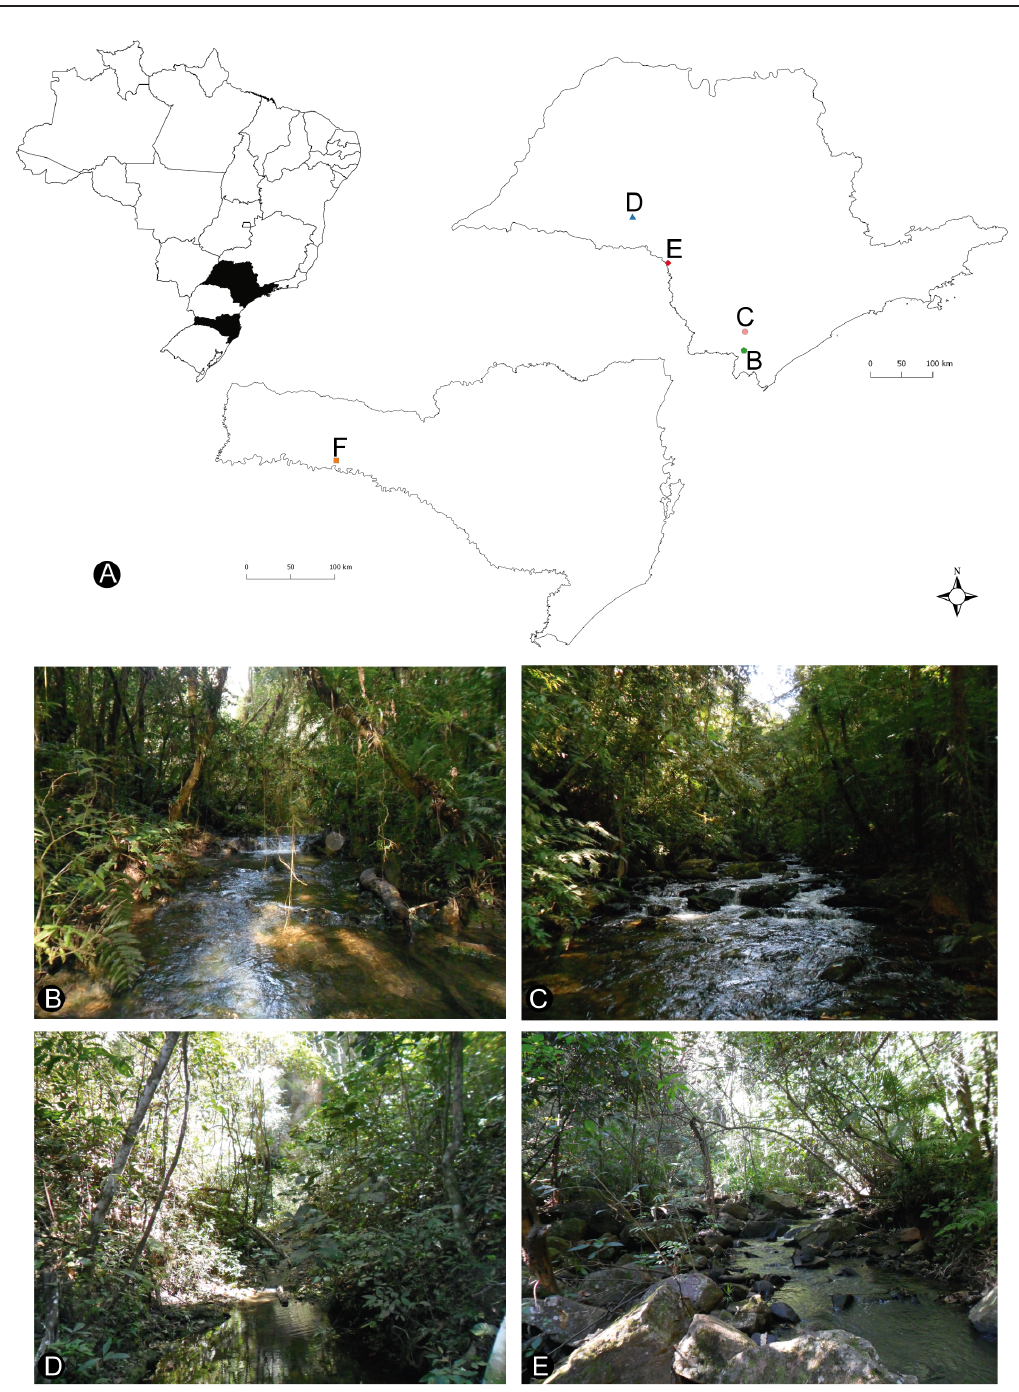
Fig. 10. Distribution records for Spanglerelmis Polizei & Bispo gen. nov. A . Map of Brazil highlighting the São Paulo and Santa Catarina States, showing the localities of Spanglerelmis gen. nov. B – D . Locality of Spanglerelmis xiririca gen. et sp. nov. B . Parque Estadual Caverna do Diabo, Eldorado, São Paulo State, Brazil (type locality) (24°38′00.7ʺ S, 048°24′32.7ʺ W). C . Parque Estadual de Intervales, Ribeirão Grande, São Paulo State, Brazil (24°16′16ʺ S, 048°25′31ʺ W). D . Echaporã, São Paulo State, Brazil (22°25′06.9ʺ S, 050°12′0.9ʺ W). E . Type locality of Spanglerelmis timburi gen. et sp. nov. Timburi, São Paulo State, Brazil (23°11′01.6ʺ S, 049°37′49.2ʺ W). F . Type locality of Spanglerelmis femoralis gen. et comb. nov. Nova Teutônia (currently county of Seara), Santa Catarina State, Brazil (27°09′42.5′′ S, 052°25′28.5′′